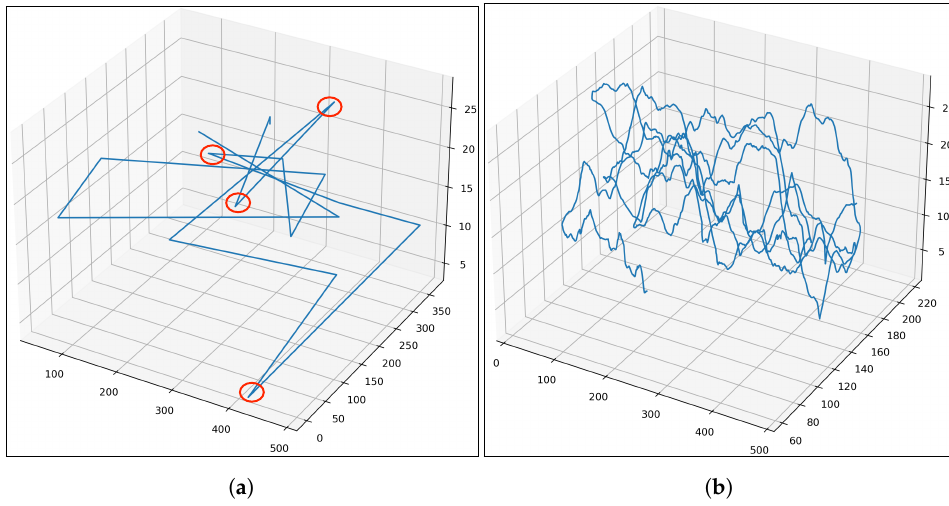
Figure 1. Sample paths under ( a ) random waypoint; ( b )